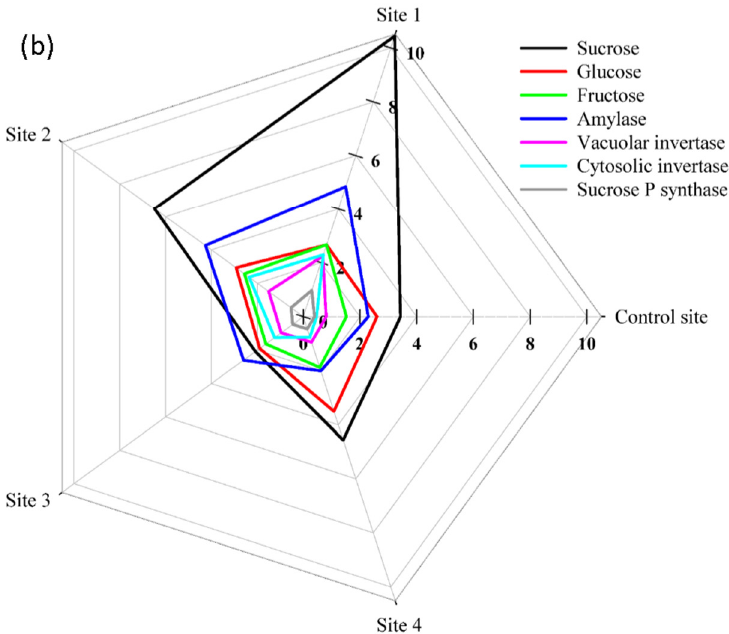
Figure 3. The concentration of sucrose, glucose, fructose (mg g − 1 ), and the enzymes involved in their metabolism and biosynthesis (pmol ml − 1 ) in the shoot ( a ) and root ( b ) of S. portulacastrum plants at different levels of heavy metals pollution.